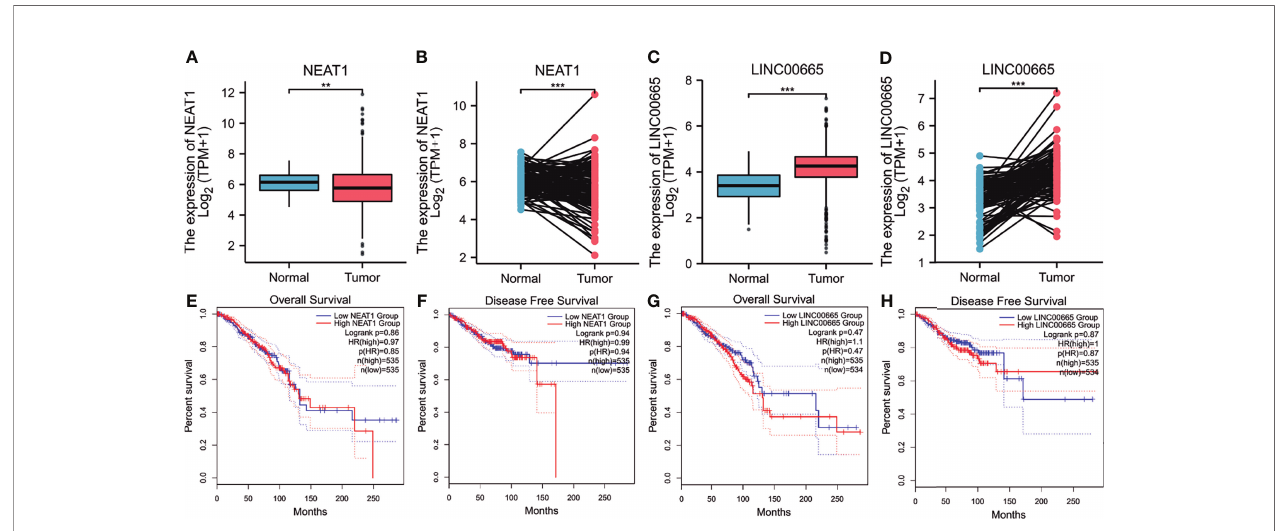
FIGURE 6 | Expression analysis and survival analysis for upstream lncRNAs of hsa-miR-410-3p in BRCA. (A – D) The expression of NEAT1 (A, B) and linc00665 (C, D) in TCGA BRCA samples compared with “ TCGA and GTEx normal tissues of unpaired samples ” or “ TCGA paired samples ” data. (E – H) The OS analysis for NEAT1 (E) and LINC00665 (G) in BRCA. The RFS for NEAT1 (F) and LINC00665 (H) in BRCA. *p value < 0.05. **P < 0.01; ***P < 0.001.